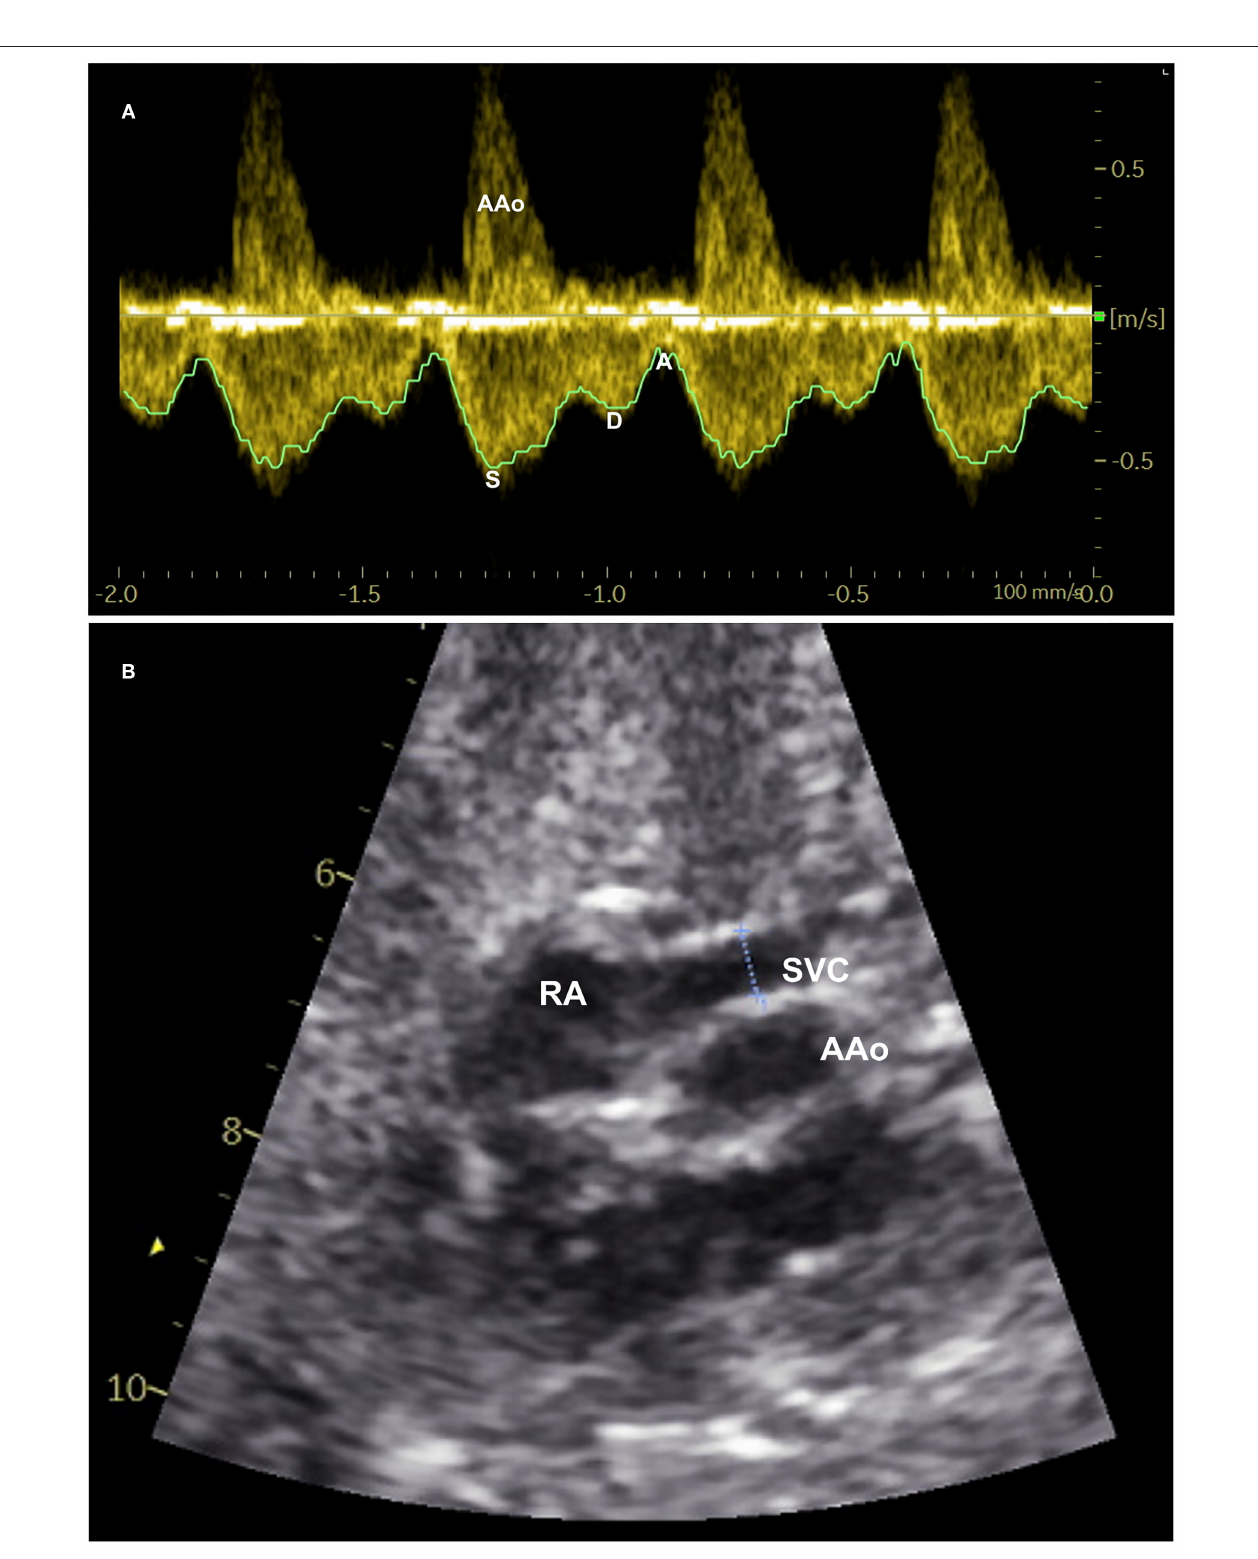
FIGURE 1 | Measurement of superior vena cava (SVC) blood flow: (A) Spectral pulsed-wave Doppler velocity waveforms of the fetal SVC with tracing of maxium velocity envelope over cardiac cycles to measure time-averaged maximum velocity. S-maximum velocity during systole, D-peak velocity during diastole, and A-minimum velocity during atrial contraction. (B) Two-dimensional B-mode ultrasound image of SVC demonstrating measurement of its inner diameter (dotted line between two calipers) shortly above the entrance to the right atrium (RA). AAo-Ascending aorta.